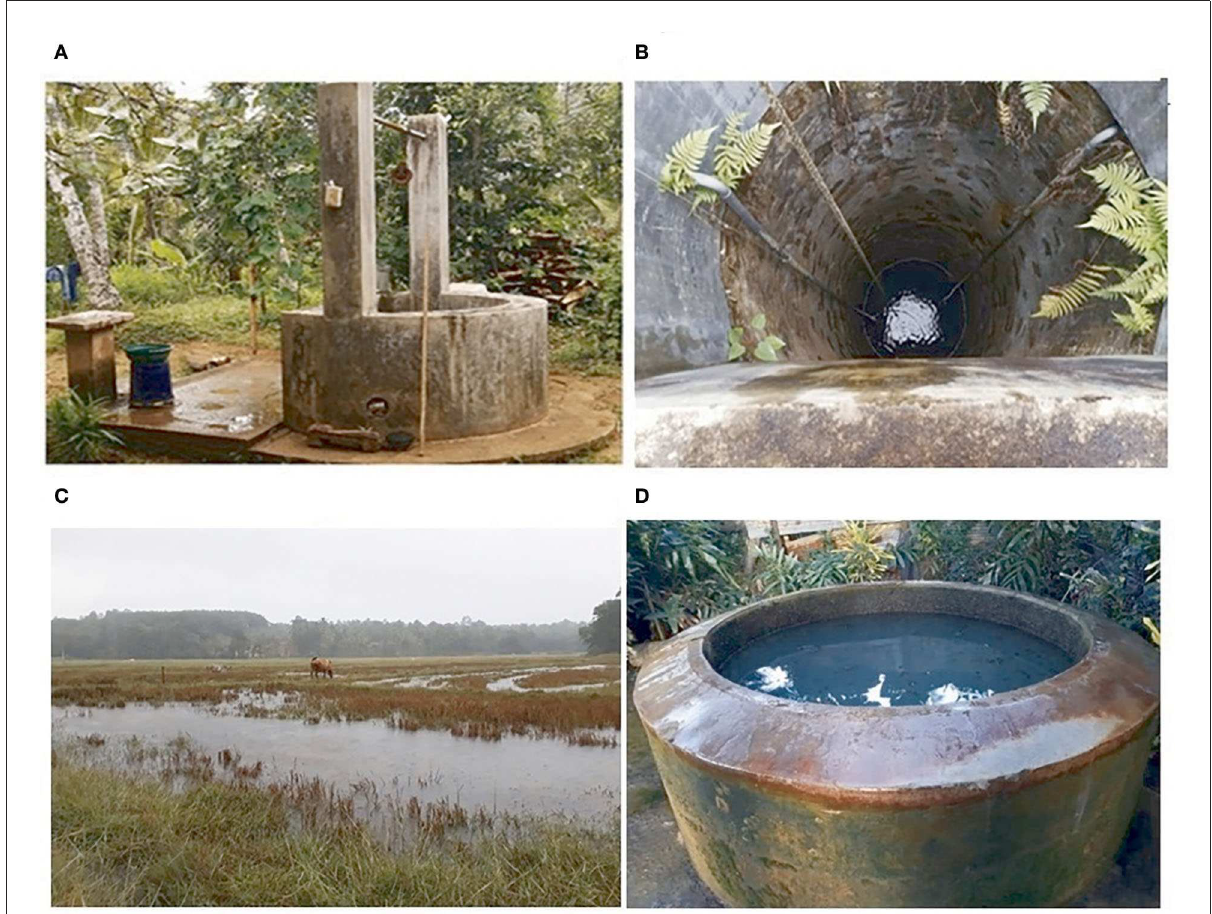
FIGURE2 Natural water sources of Burkholderia pseudomallei . (A, B) unchlorinated domestic well (C) Stagnant water in paddy field (D) perennial spring “Bubula”.